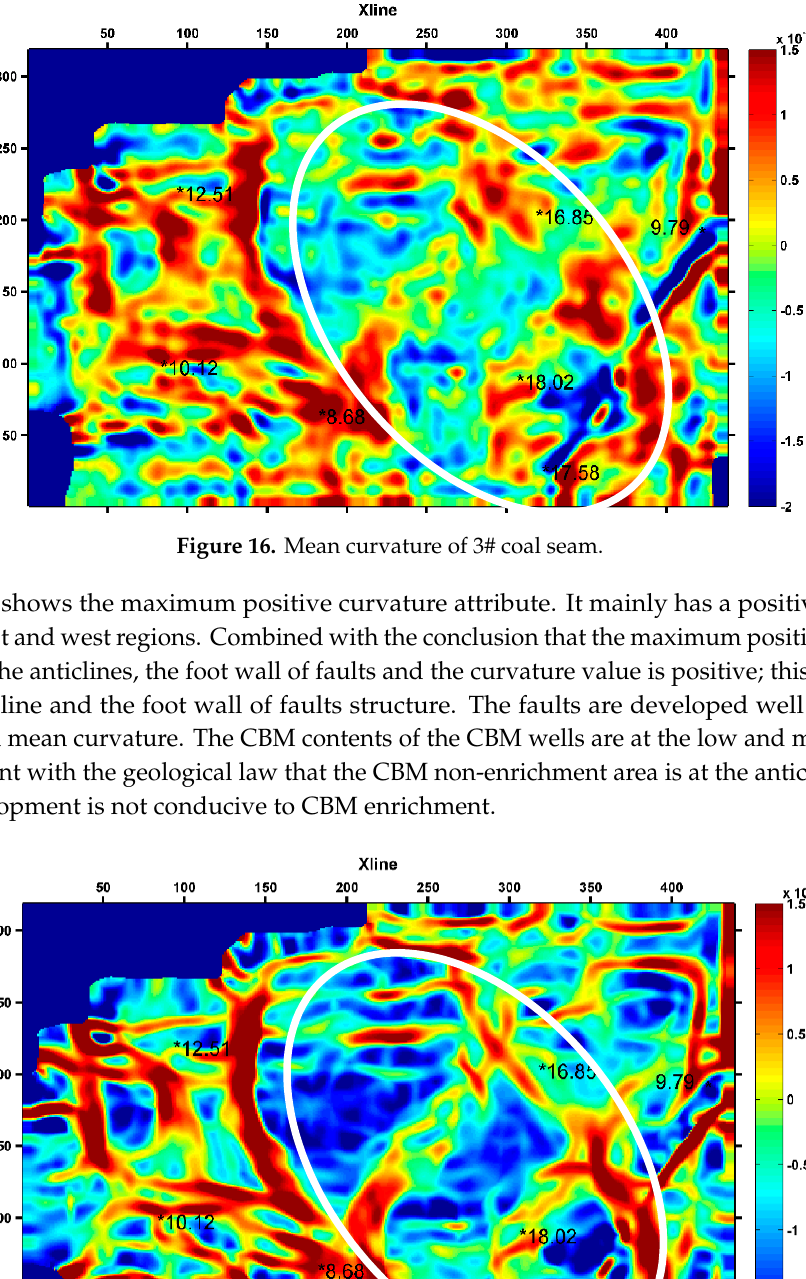
Figure 18. Negative curvatures curvature of 3# coal seam. Above the comprehensive analysis of mean curvature, maximum positive curvature and minimum negative curvature, the anticline structures mainly develop in the east and west regions